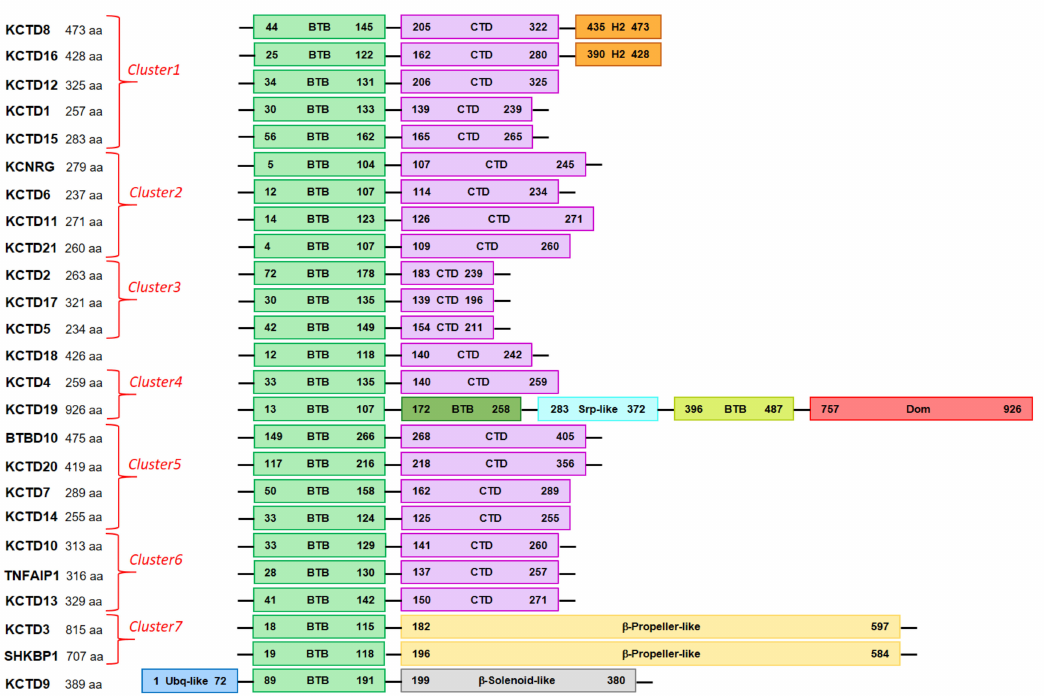
Figure 2. Schematic representation of protein domain organization. For the KCTD10, KCTD13, and TNFAIP1 proteins, AF predicts that a potential β -strand of the flexible C-terminal region could join the β -sheet of the CTD domain. The Dom domain of KCTD19 presents some similarity to the TAFH